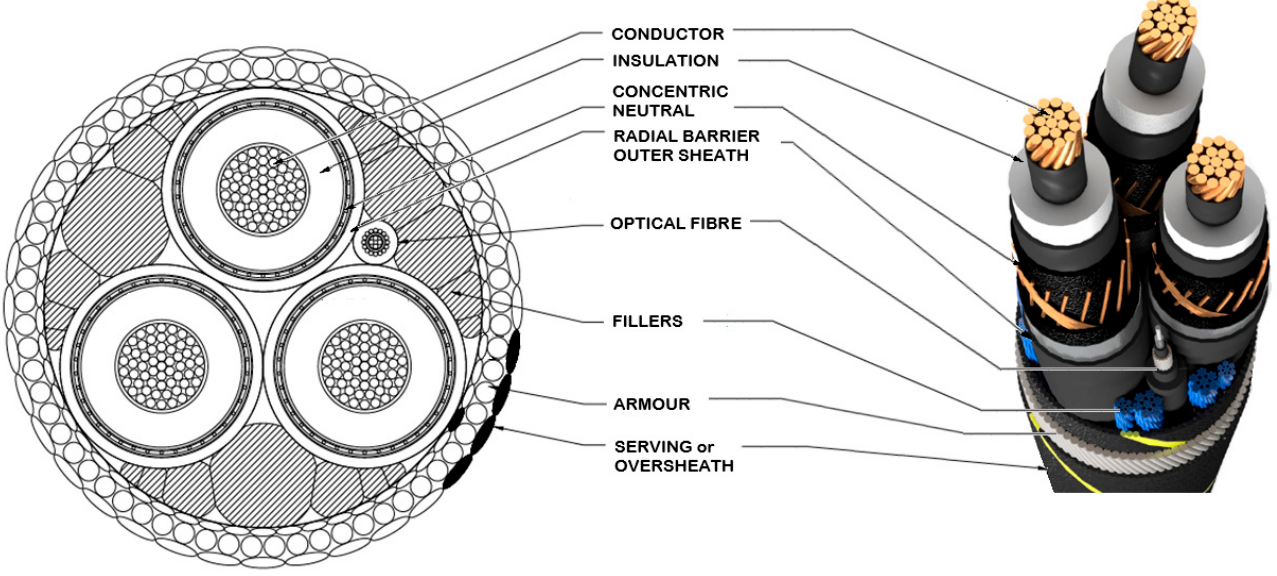
Figure 1. Example construction of a common inter-array cable.